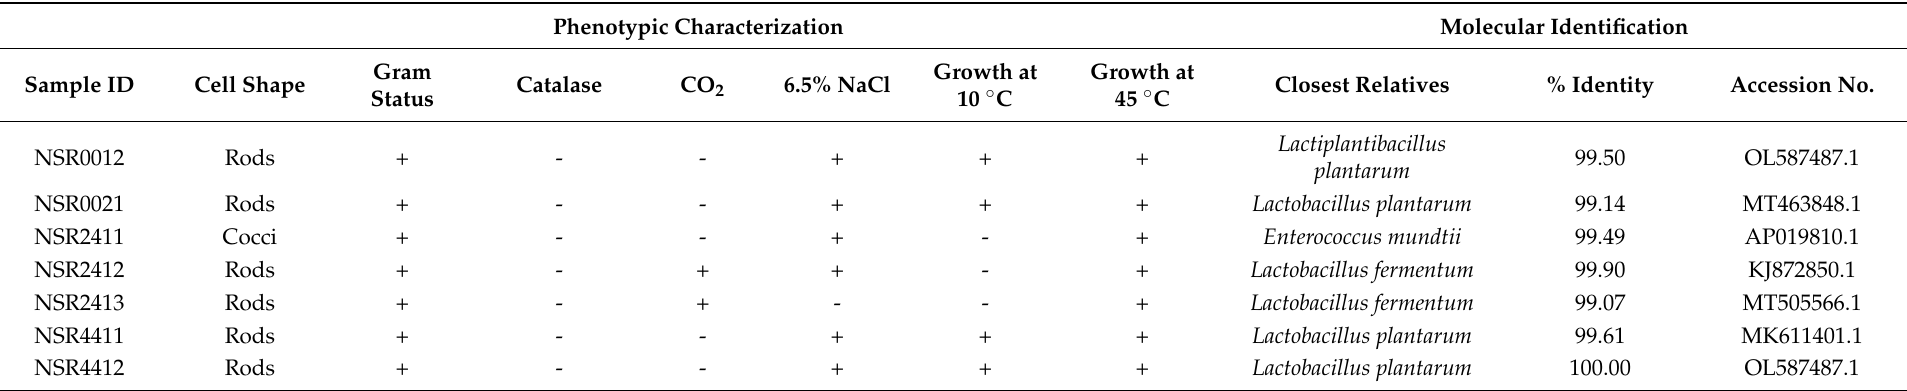
Table 2. Phenotypic and molecular identification of lactic acid bacteria from African nightshade